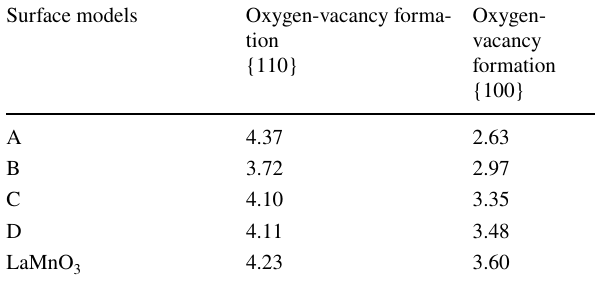
Table 1 Calculated oxygen vacancy formation energies (in eV) of LaMnO- {110} and MnO 2 -terminated {100} LBM25 surfaces with Hubbard U correction (U eff = 4 eV) Surface